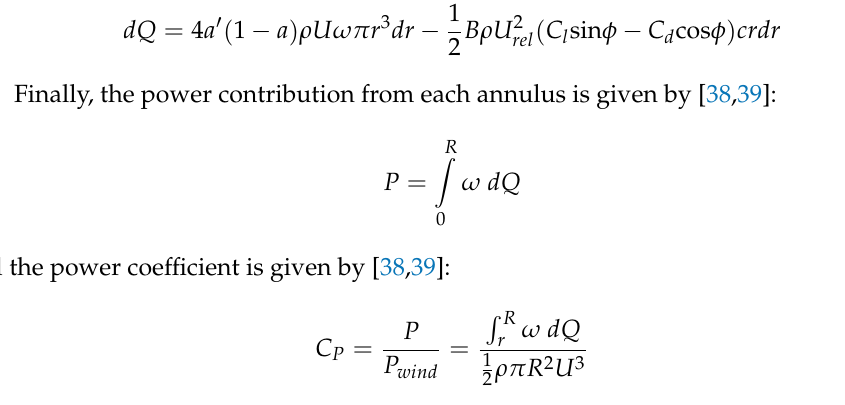
dynamic characteristics of the airfoils, their position r , their pitch angle β , the angle of incidence α , the upstream wind speed U , and the rotational speed ω . The previous velocity triangle (see Figure 3) for an airfoil can be reduced to the relative velocity U rel and the angle of attack α , used as an input parameter for the CFD calculations [39]. The power output of a turbine analyzed using BEM is typically underestimated due to assumption, particularly at low tip speed ratios. Still, the power coefficient tends to be overestimated in high solidity rotors [39,40]. However, span-wise flow exists and is caused by the centrifugal force generated by blade rotation. Therefore, the radial cross-flow is unstable, generating steady and trailing vortices that cause delays in flow separation,